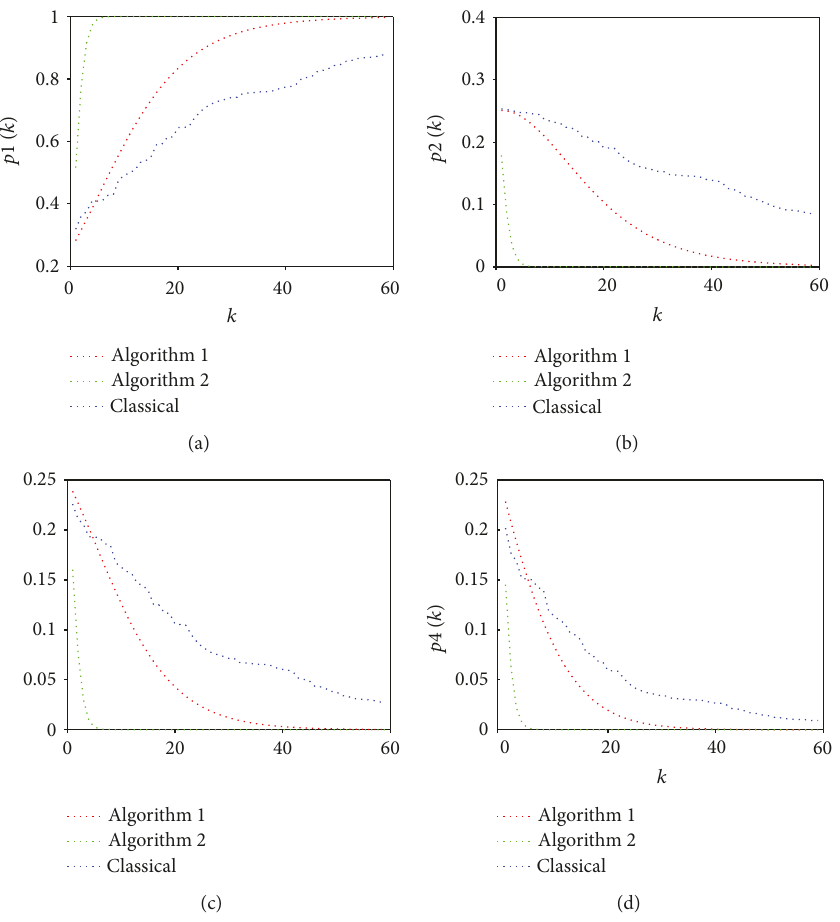
Figure 5: The weight signals of three weighting algorithms in Case